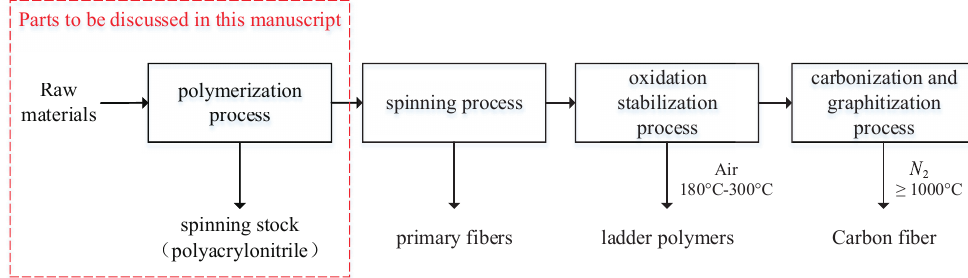
Figure 1. Carbon fiber production flow